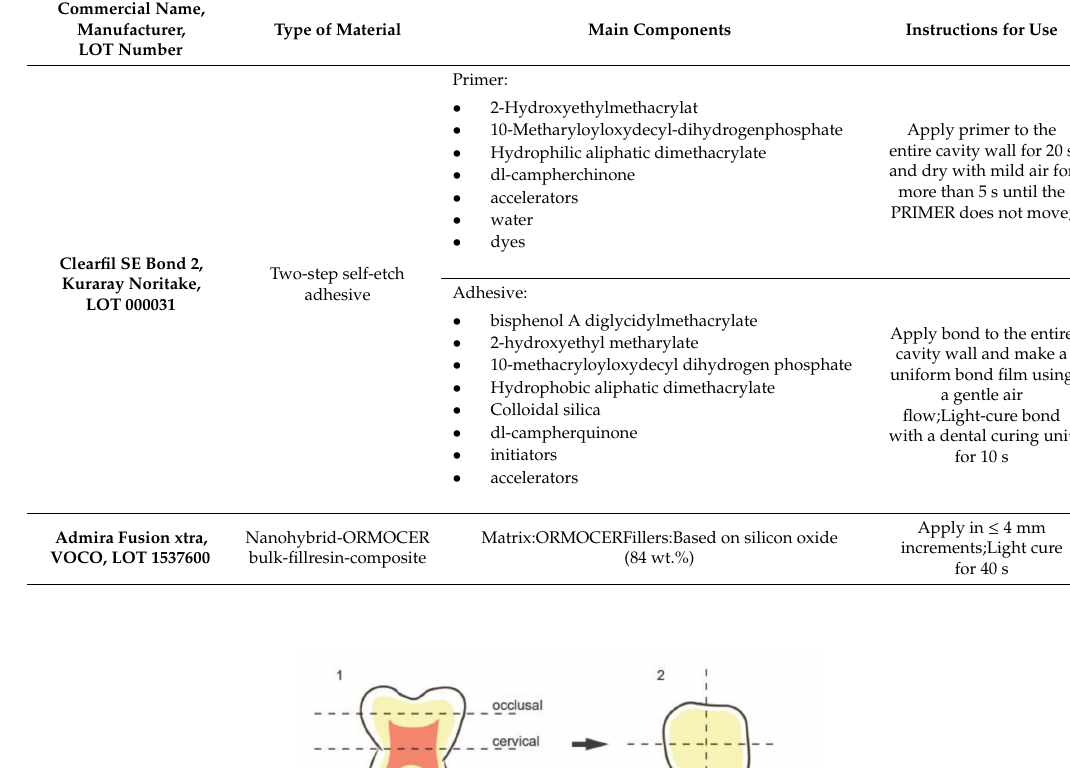
Table 1. Characterization and composition of materials.